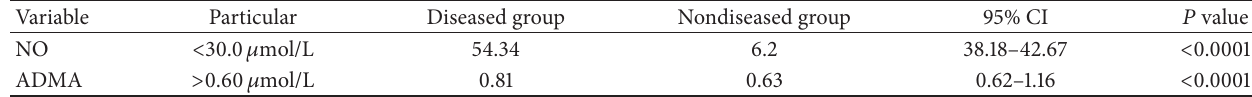
Table 4: Univariate analysis of cofounding factors.